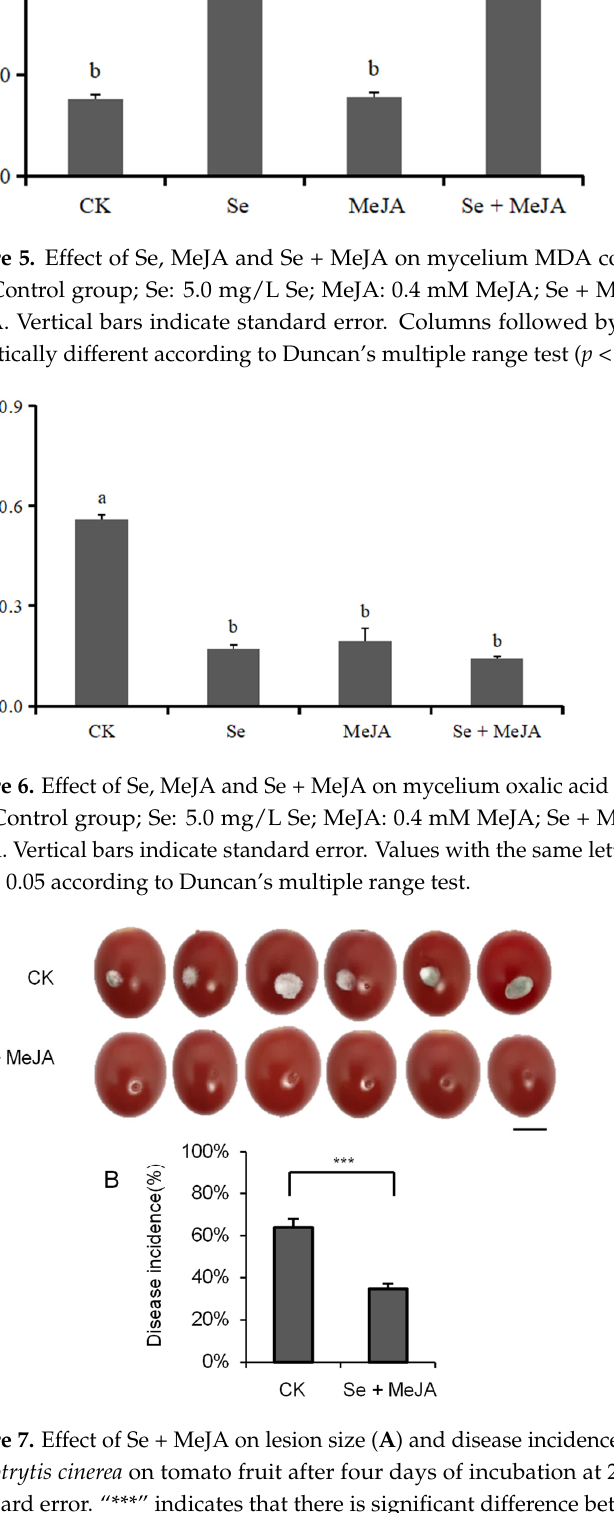
Figure 5. Effect of Se, MeJA and Se + MeJA on mycelium MDA content of Botrytis cinerea (n = 4). CK: Control group; Se: 5.0 mg/L Se; MeJA: 0.4 mM MeJA; Se + MeJA: 5.0 mg/L Se with 0.4 mM MeJA. Vertical bars indicate standard error. Columns followed by different lowercase letters are statisti- cally different according to Duncan’s multiple range test ( p < 0.05).